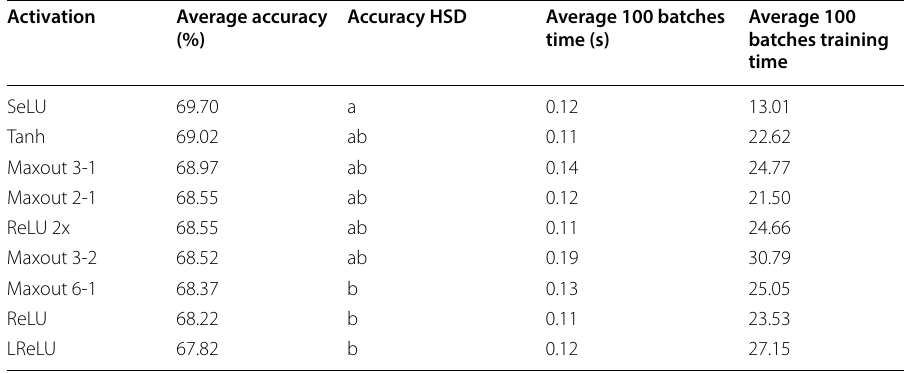
Table 12 Activation HSD test on medical datasets